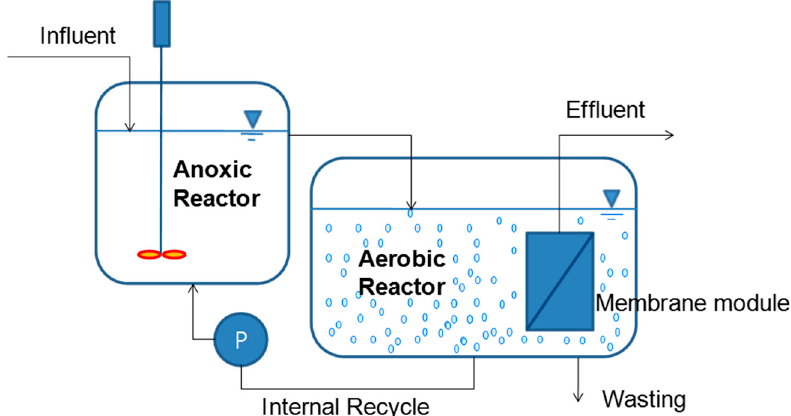
Figure 1. Schematic diagram of the MLE-type MBR.